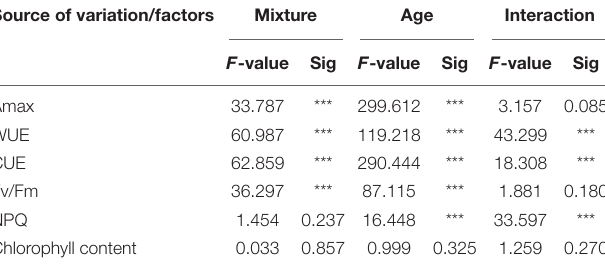
TABLE 3 | Results of two-way ANOVA on the effects of mixture and age on photosynthetic performance parameters. Source of